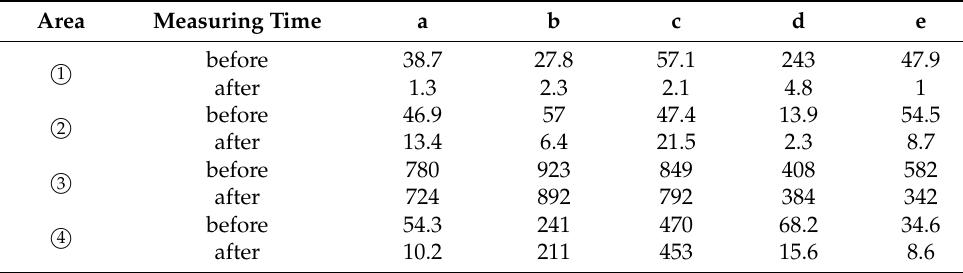
Table 3. Concrete height values before and after cleaning in each area ( µ m).